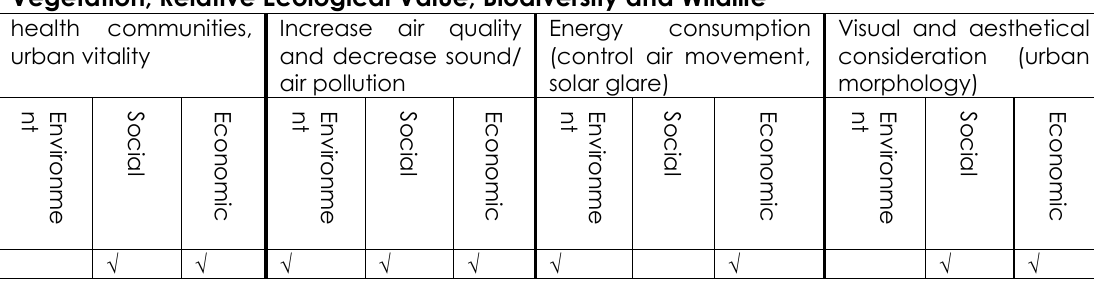
√ √ √ √ √ √ √ √ √ Table 4. Integration between Plants, Wildlife Properties and Dimension of Sustainability. Soil and water quality are the other significant sources to improve plants, wildlife, ecological and biodiversity values which have deep